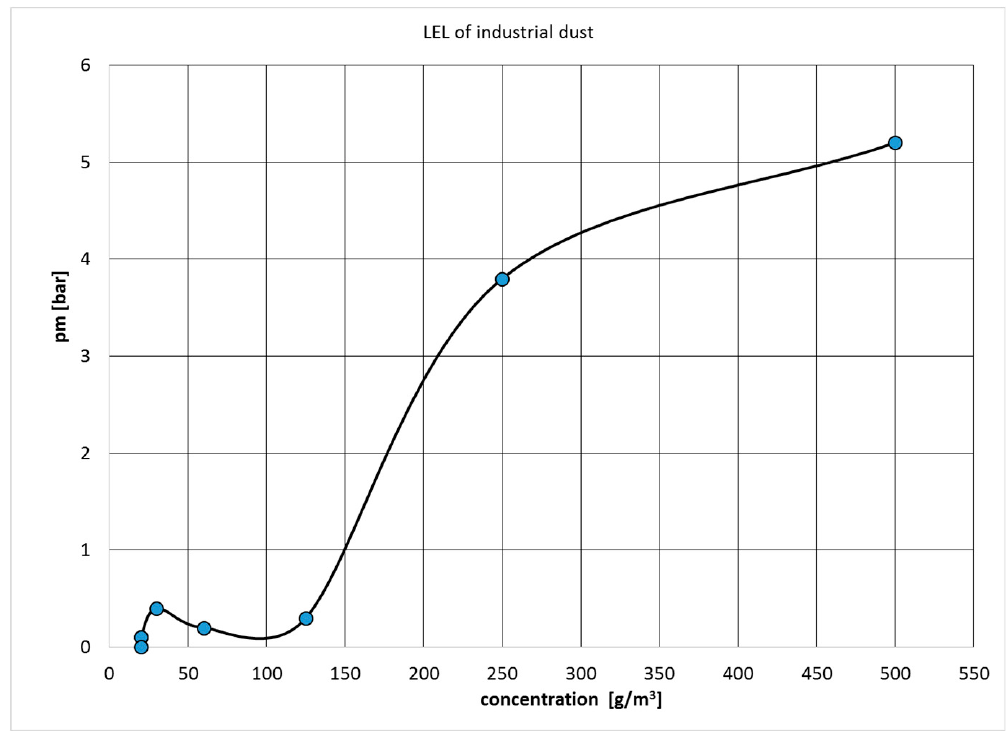
Figure 6. Determinate of industrial dust´s lower explosive limit (LEL).